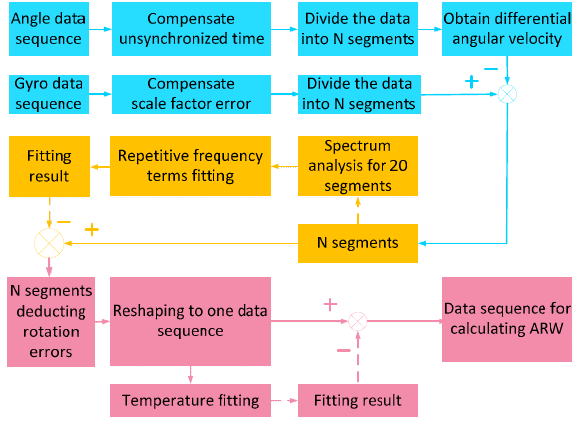
Figure 8. Flow of the process.